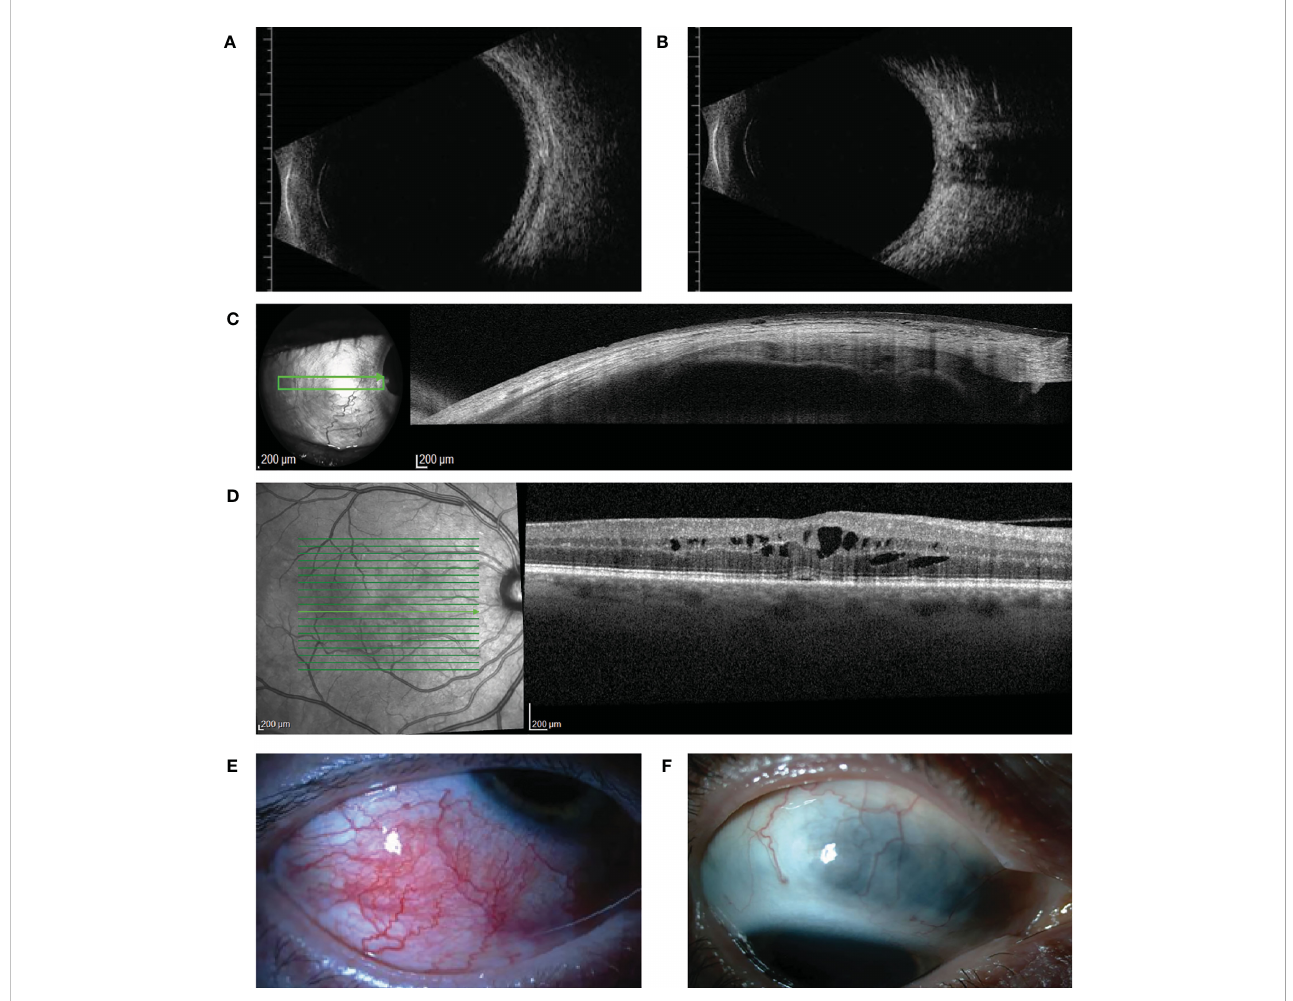
FIGURE 1 Ultrasound B-scan, optical coherence tomography (OCT) fi ndings, and clinical illustrations of our cases (A, B) show ultrasound B-scan images of case 3 with active posterior scleritis. Thickening of the sclera-choroidal complex and fl uid accumulation in the episcleral space is seen in (A, B) shows fl uid accumulation between the optic nerve and the sclera, the for scleritis typical T-sign. (C) shows an anterior segment OCT image of case 1, in which thinning of the sclera as a result of scleral necrosis is seen. (D) shows cystoid macular edema of case 1, a complication of active scleritis. (E, F) show clinical images of respectively case 5 (acute phase of anterior scleritis) and case 10 (quiet stage of previous anterior nodular scleritis following treatment, which exhibits scleral